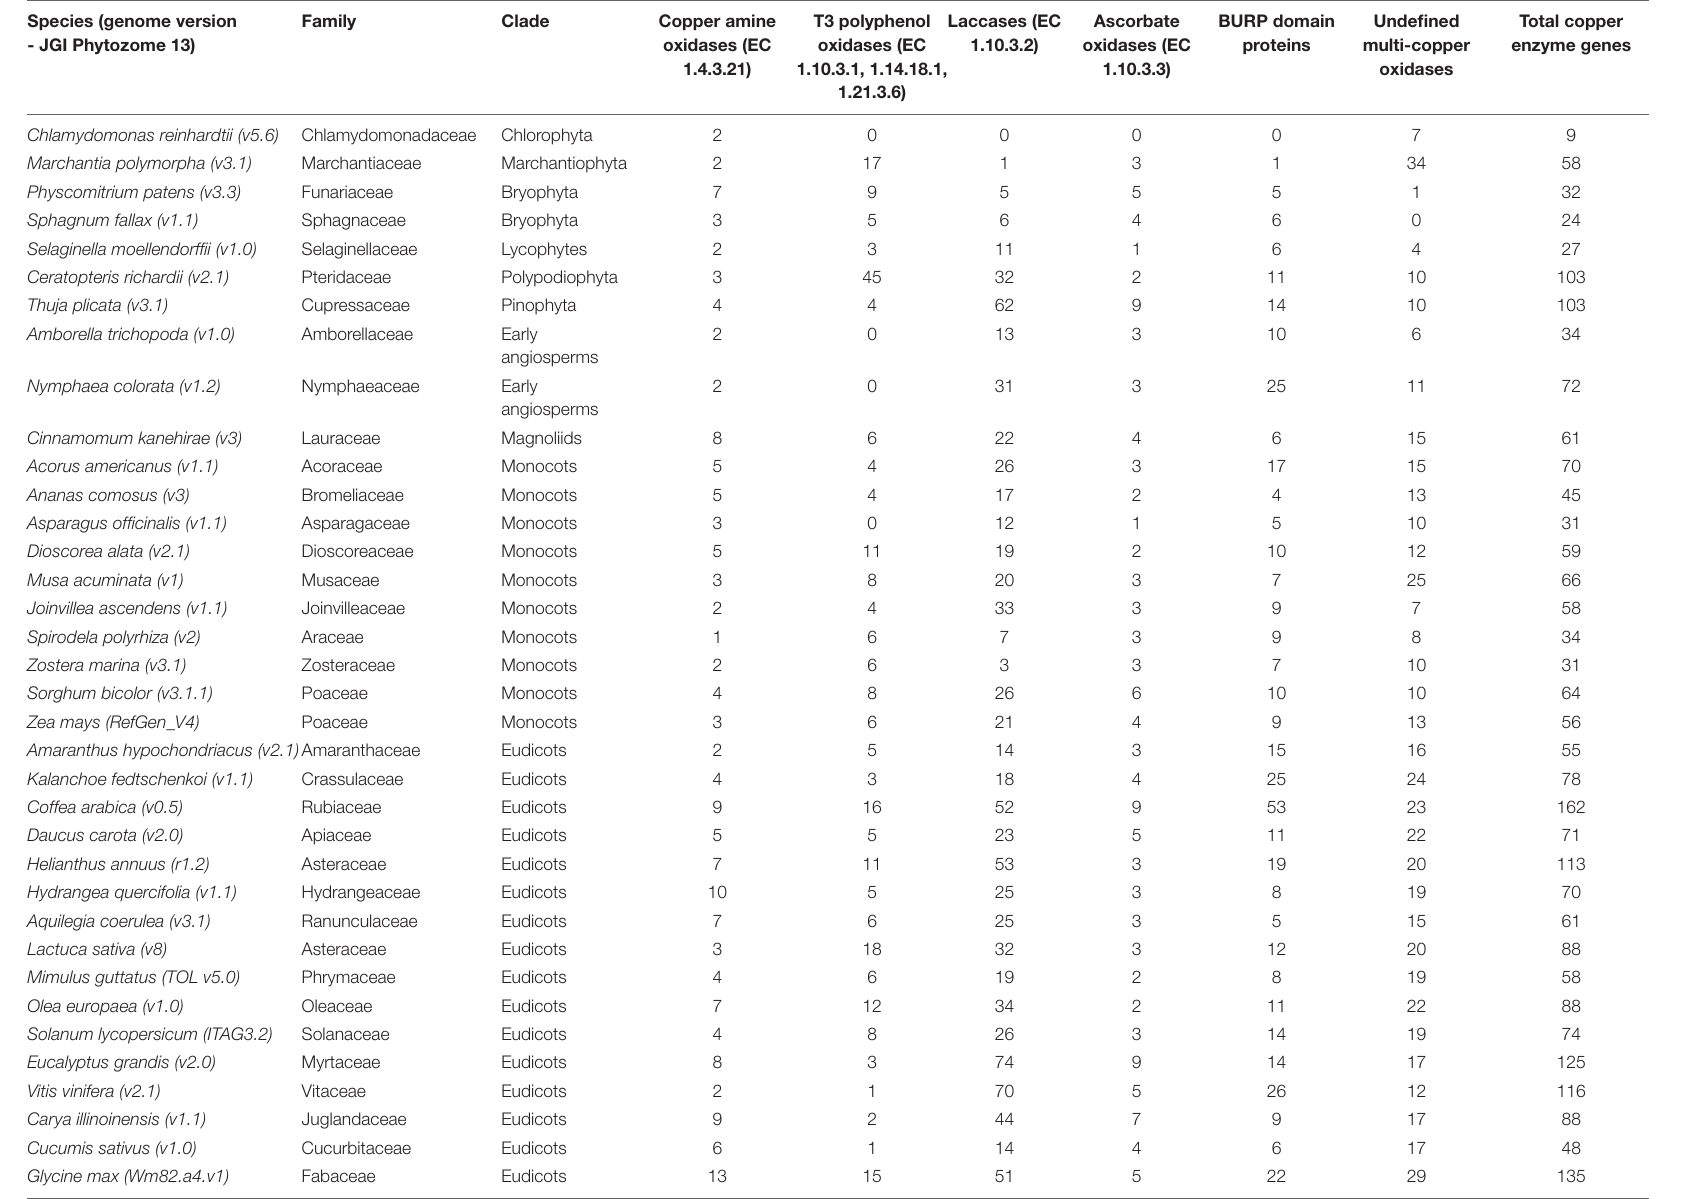
TABLE 2 | Genome mining of plant copper